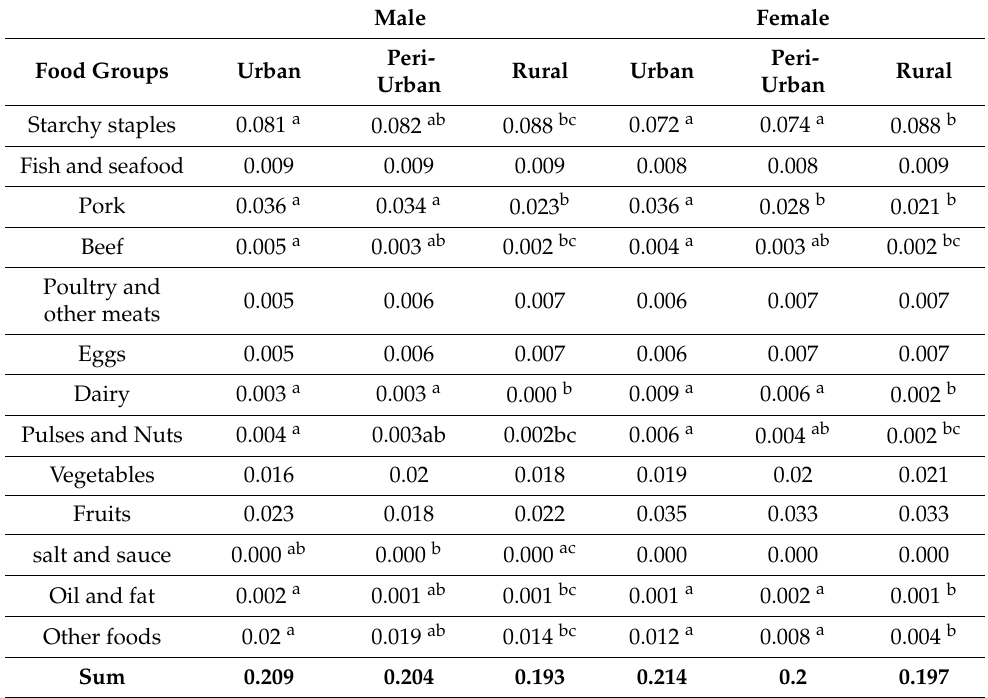
Table A7. Blue water use per 2000 Kcal by food group, gender, and